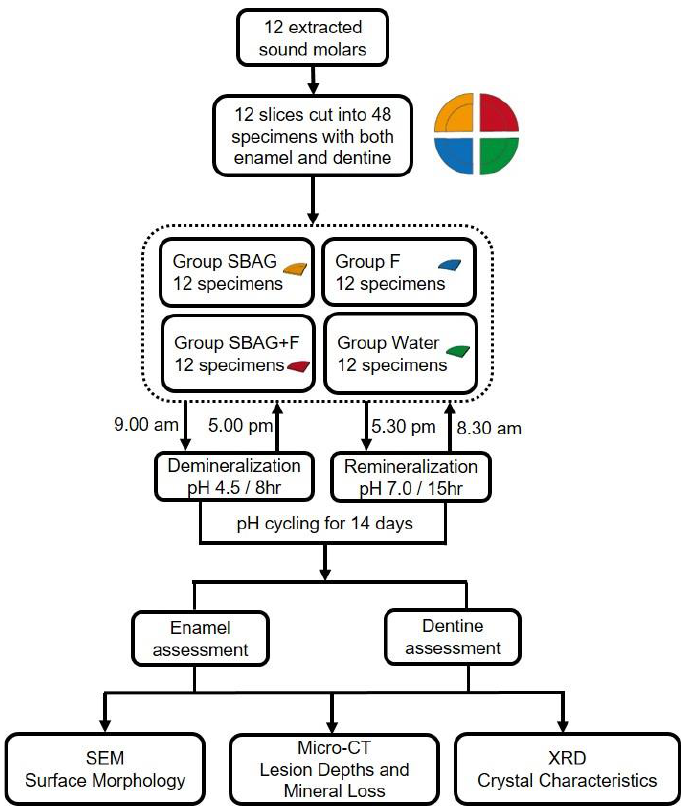
Figure 1. The flowchart of the experimental procedure.